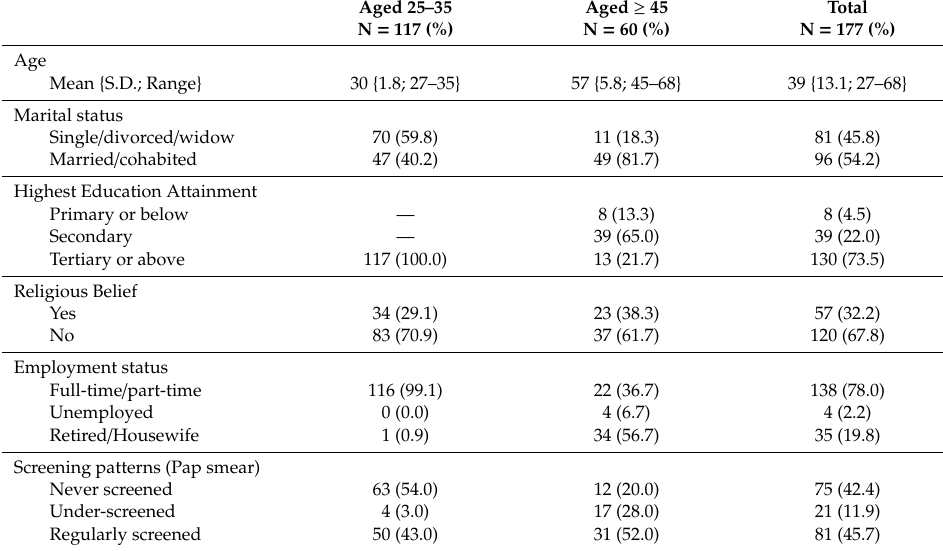
Table 1. Demographic characteristics among those who responded to the